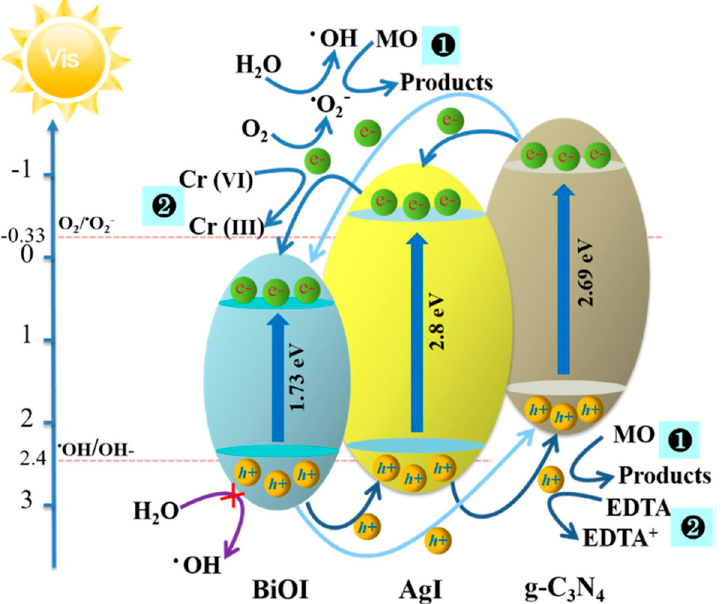
Figure 4. The possible proposed photocatalytic mechanism for MO dye degradation (path 1), show- ing the BiOI/AgI/g − C 3 N 4 composites’ irradiation under visible − light. Reprinted/adapted with per- mission from [115], 2023, Springer Nature (License Number